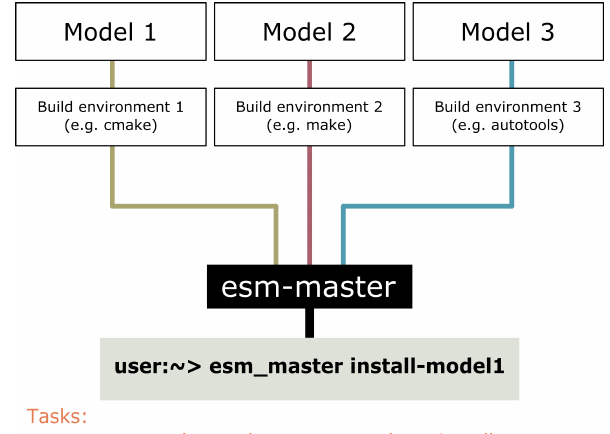
Figure 6. Schematic of the esm_master tool, which provides generic building commands that map to each model-component- specific building environment. Further generic tasks are comp-, update-, clean-, status-, log-, install- and